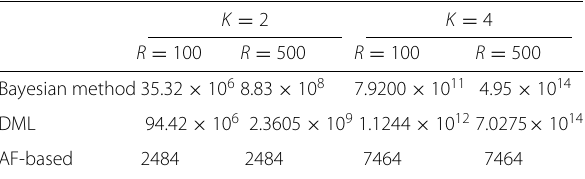
Table 1 Complexity of the three single-shot techniques with N a = 16 receiving antenna branches K = 2 K =